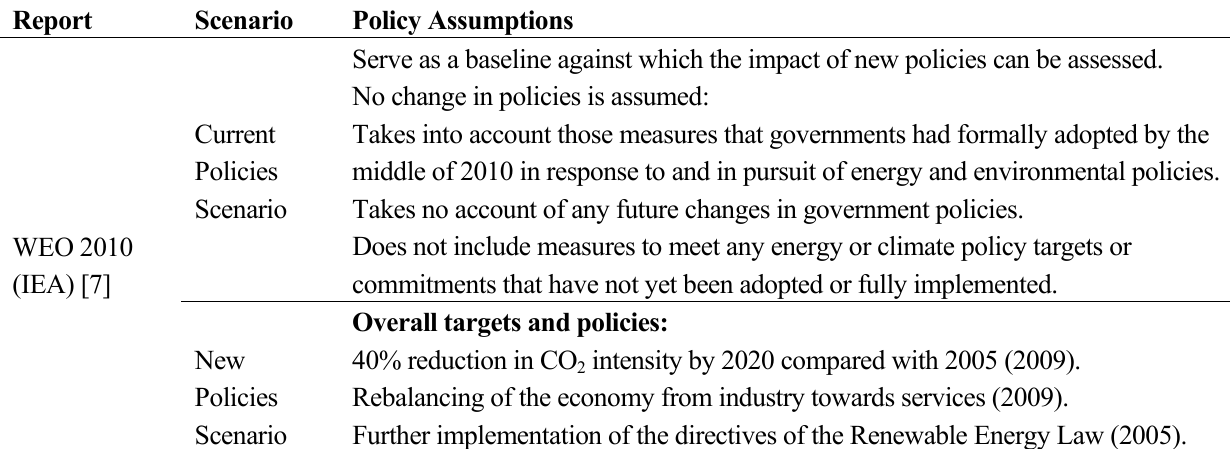
Table 1. Scenario policy